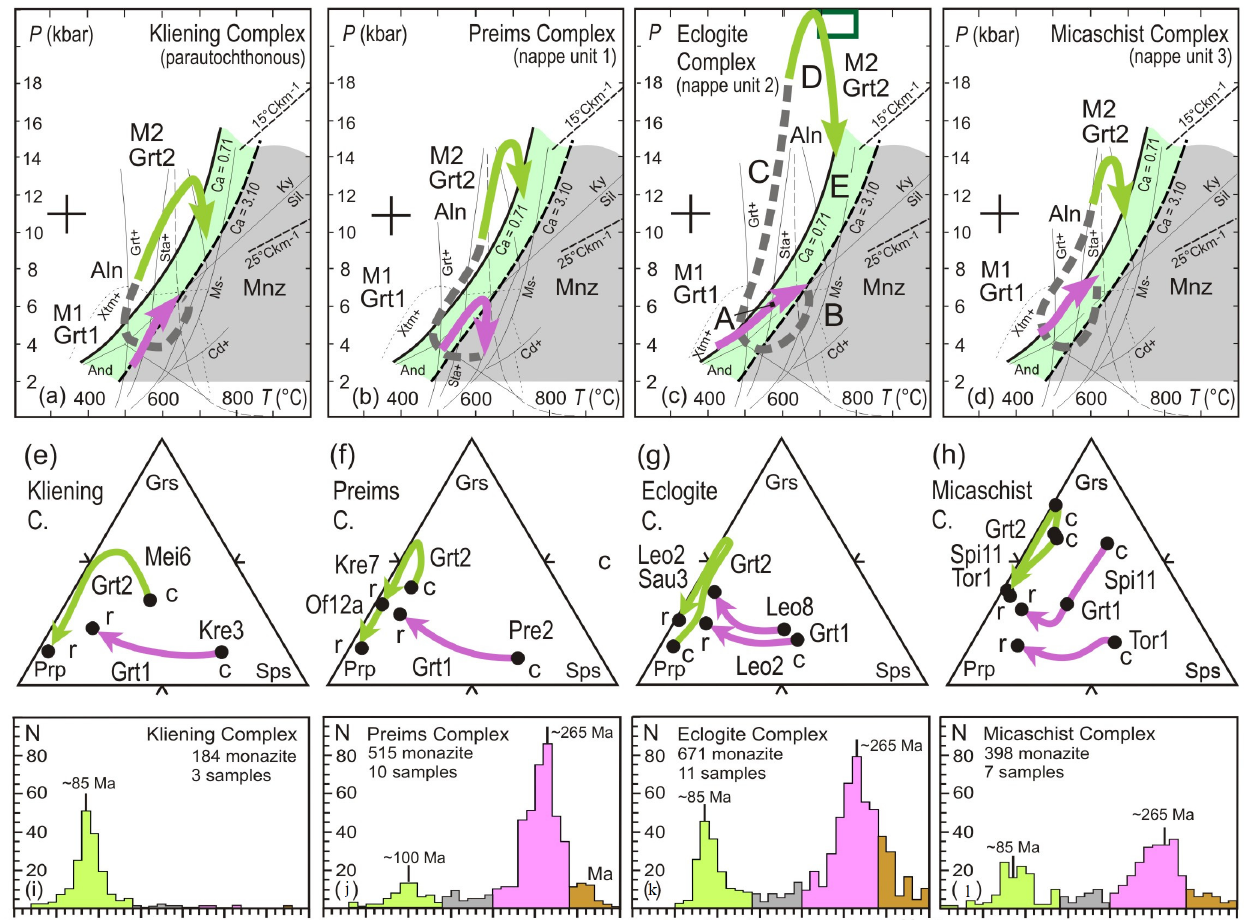
Figure 6. P-T paths, garnet zonations and EPMA Th-U-Pb monazite ages in the complexes of the Saualpe nappe stack in the Austroalpine Domain. ( a – d ) P-T paths by microstructurally controlled geothermobarometry from garnet core-to-rim zonations in the complexes from the lowermost Kliening Complex toward the Micaschist Complex in the hanging wall [27,29]. P-T paths of metamorphism 1 and garnet 1 (M1, Grt1) in violet are related to Permian ages, P-T paths of metamorphism 2 and garnet 2 (M2, Grt2) in green are related to Cretaceous ages. Aluminosilicates (and Ky, Sill), cordierite-in (Cd+), muscovite-out (Ms-) and staurolite-in and -out (Sta+, Sta-) univariant lines [30]. Stability fields (green and gray) of monazite (Mnz) and allanite (Aln) at different bulk rock contents as a function of Ca wt%, and with the xenotime (Xtm) stability field. Bold cross was uncertainty of ±50 °C/±1.0 kbar on P-T estimates. Geothermobarometric data from eclogite marked in green box [71]. ( e – h ) Grossular-pyrope-spessartine (Grs-Prp-Sps) ternary diagrams of garnet core-to-rim (c, r) zonations, related to P-T paths in (a – d). ( i – l ) Histograms of monazite ages. Lack of Permian monazite ages in the lowermost Kliening Complex where no pegmatites were observed, contrasting Permian monazite populations in the other three complexes with pegmatites.